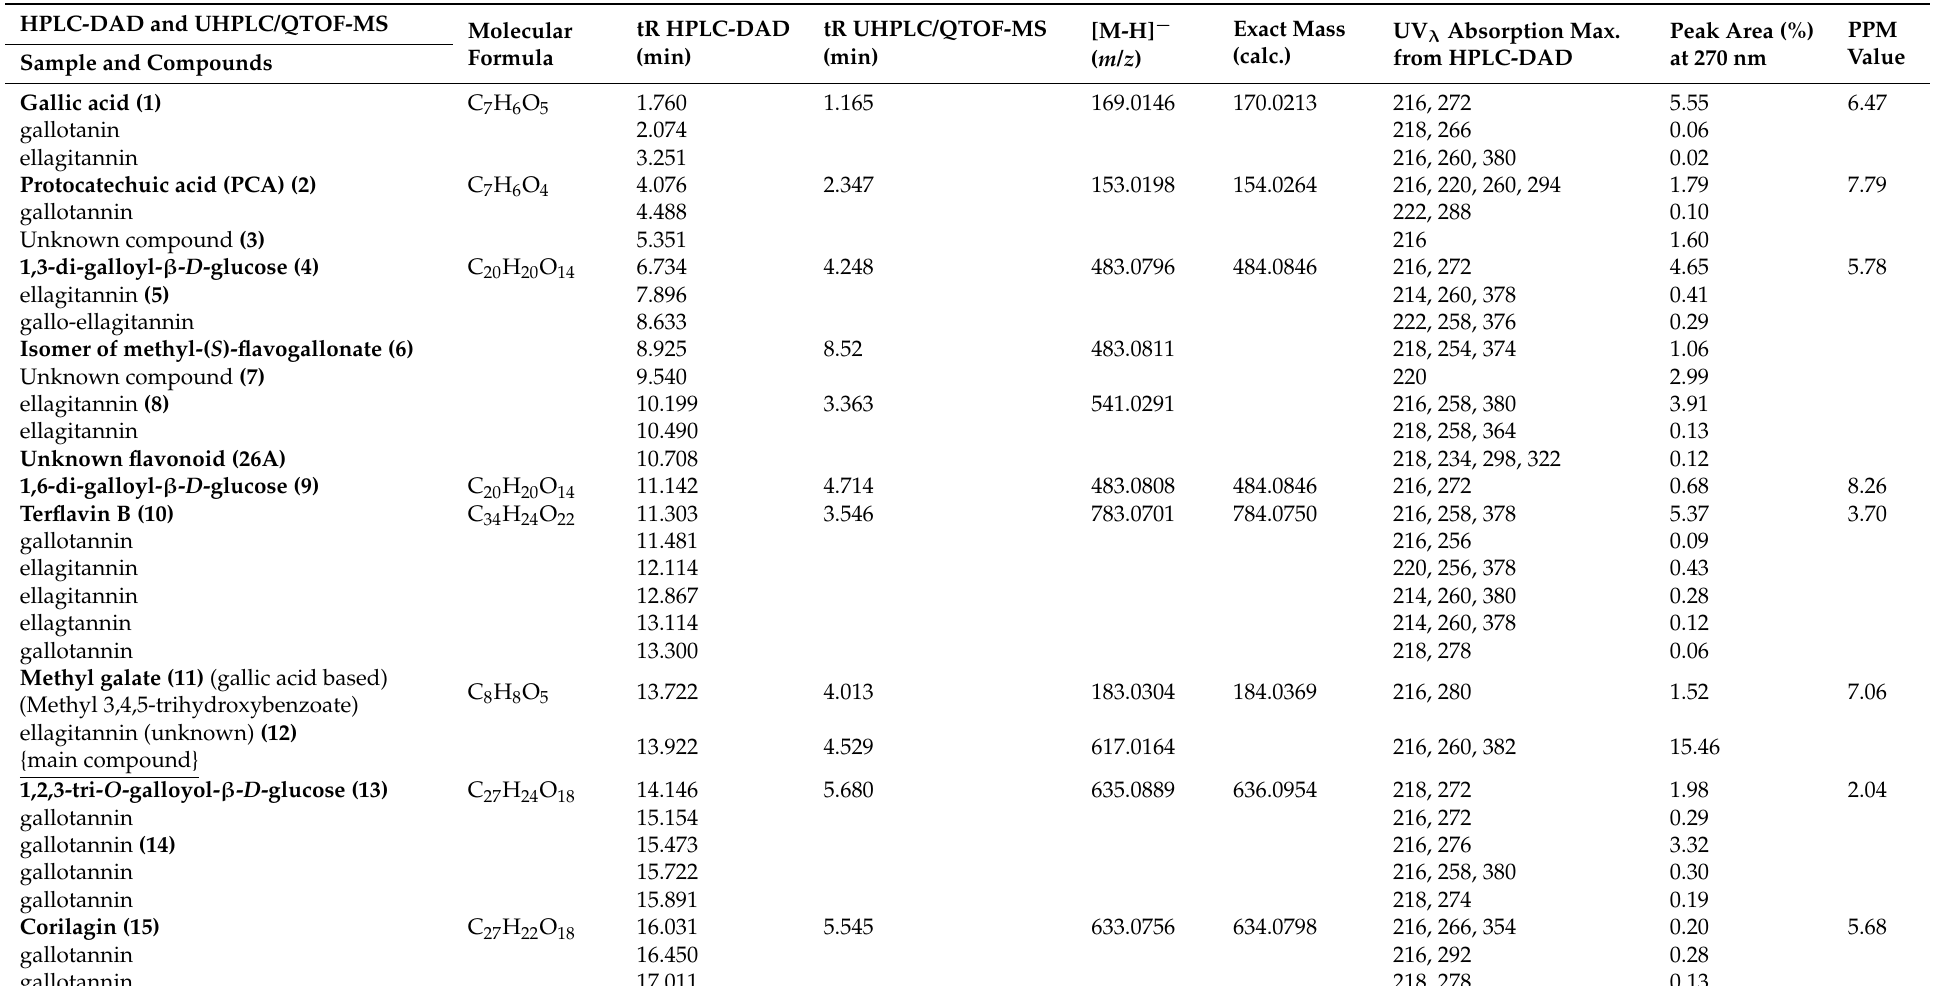
Table 3. HPLC-DAD and UHPLC/QTOF-MS data of phenols, triterpenes and polyphenolic compounds and their derivatives present in the leaf ethyl acetate extract of Terminalia brownii